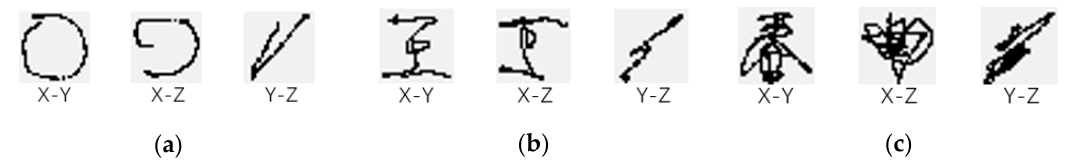
Figure 16. The three planes mapping of three gestures. ( a ) Is the simple gesture, ( b ) is the normal gesture, and ( c ) is the complex gesture.